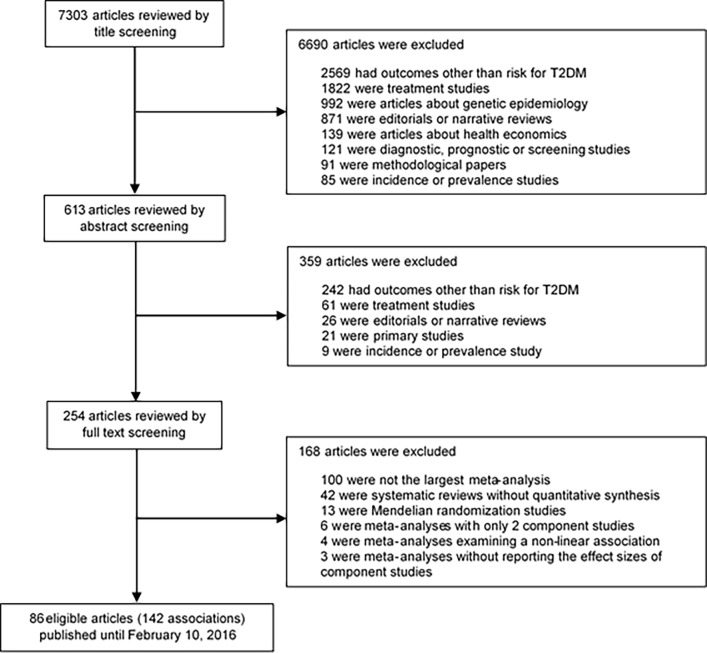
Flow chart of literature search.